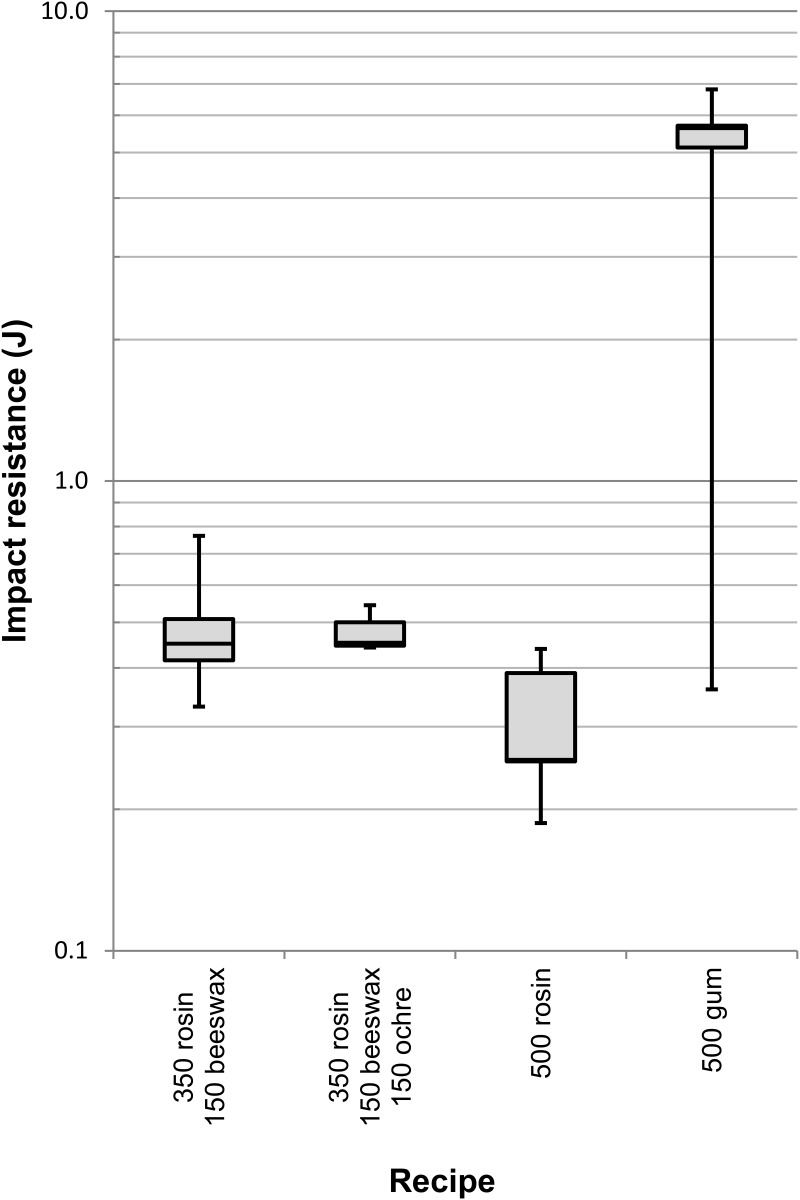
Impact test results.The logarithmic y-axis represents impact resistance in Joules for each recipe. Adhesive recipes are expressed by the mass of each ingredient (mg).